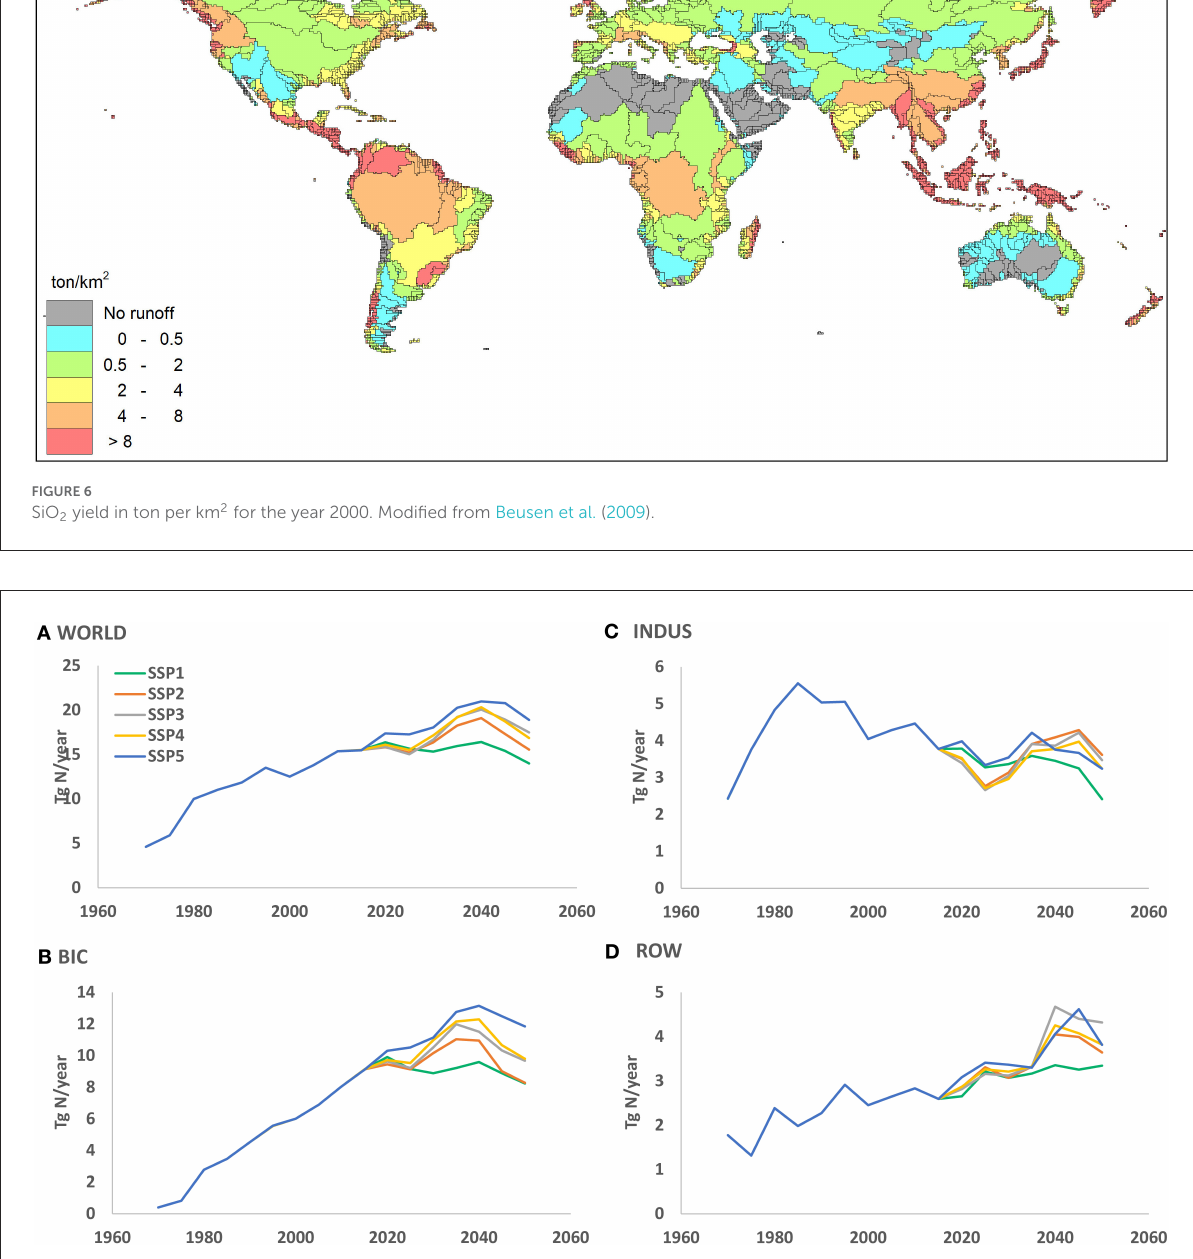
FIGURE7 River N export for rivers with dominant ( > 50%) anthropogenic N sources and N:P ratio > 25 for (A) the world, (B) INDUS, (C) BIC, and (D) ROW.